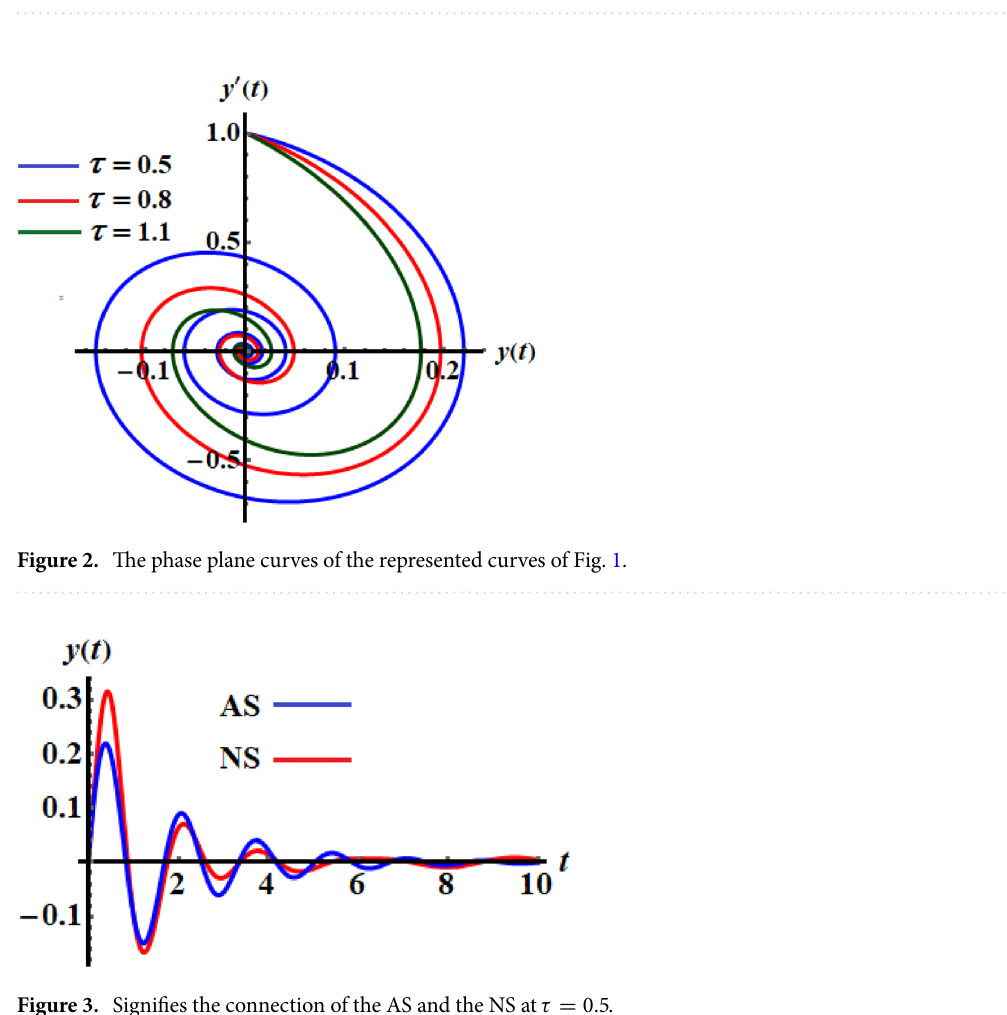
Figure 1. The temporal histories of the AS when τ( = 0.5, 0.8, 1.1 ) .